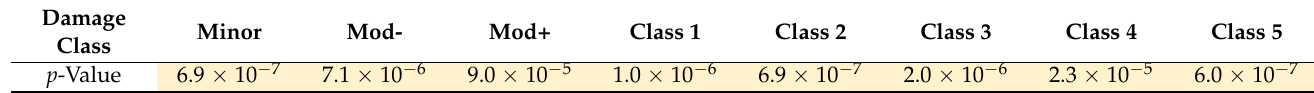
Figure 6. Box-and-whisker plots of the coherence differential value γ dif for each damage class. To examine the significant differences between Mashiki Town and Uki City in the damage classes, we ran the Mann–Whitney U test on each damage class, as well as the correlation coefficient R . The results of the test are presented in Table 4. The yellow cells indicate that a significant difference was determined. All damage classes found significant differences between Mashiki Town and Uki City. Table 4. Results of the significant difference test for Mashiki Town and Uki City in γ dif of each damage class (yellow indicates a significant difference was determined).